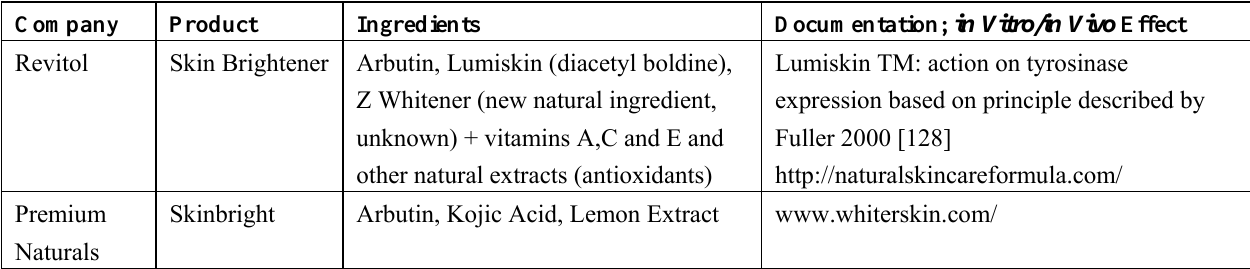
Table 3. Limited selection of whitening products available on the market with some information on active